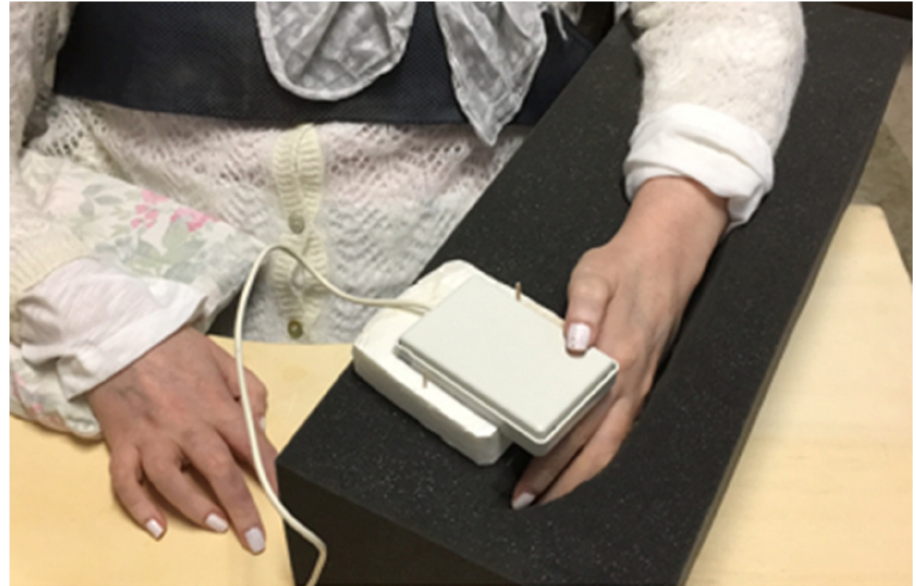
Figure 1. Finding the most suitable arm position for Lisa. In order to satisfy Lisa’s needs, different upper limb positions were tested. Finally, Lisa’s arm and hand were set in a foam pad with the thumb placed on the control switch. Lisa can voluntarily move only her left thumb; the table and the foam allow her to maintain her arms in a comfortable and stable